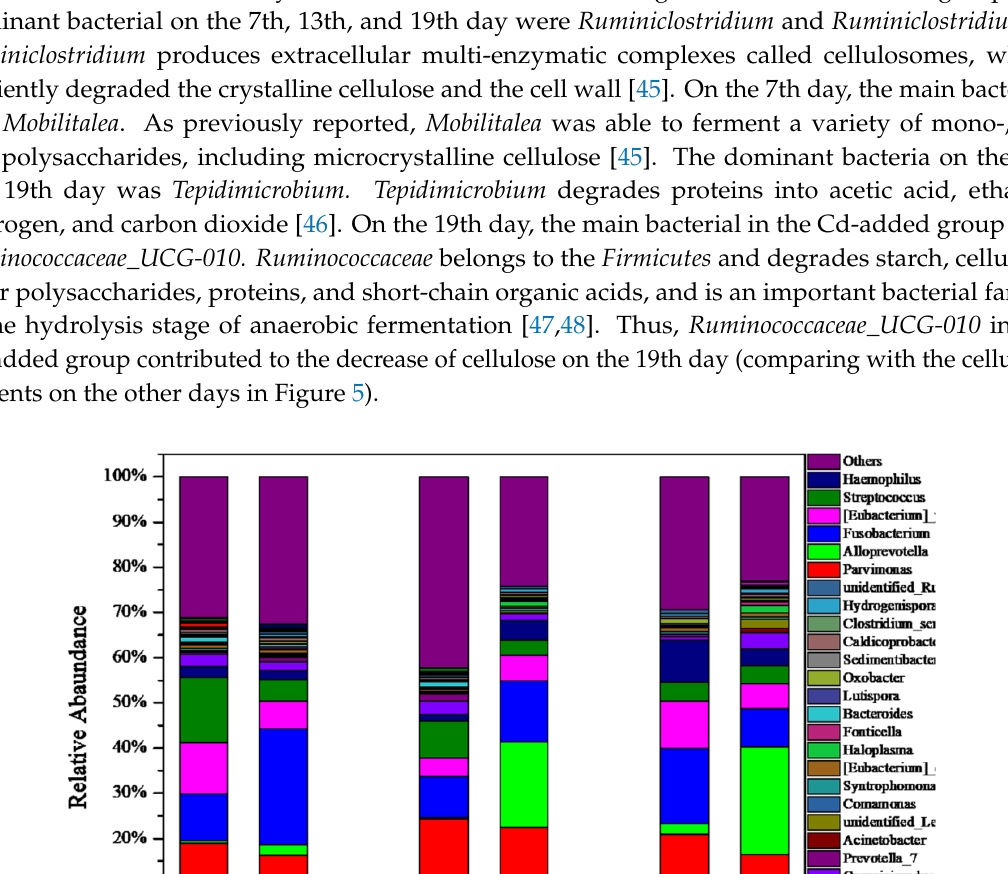
Figure 9. Impact of Cd and Cd+Zn addition on methanogen community composition during the fermentation.